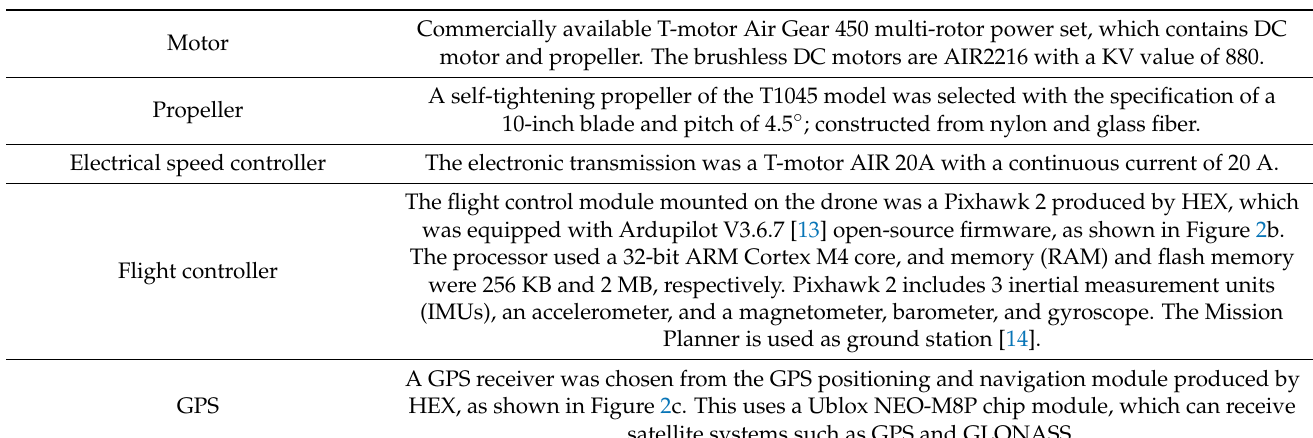
Table 1. The introduction of the components of the drones.